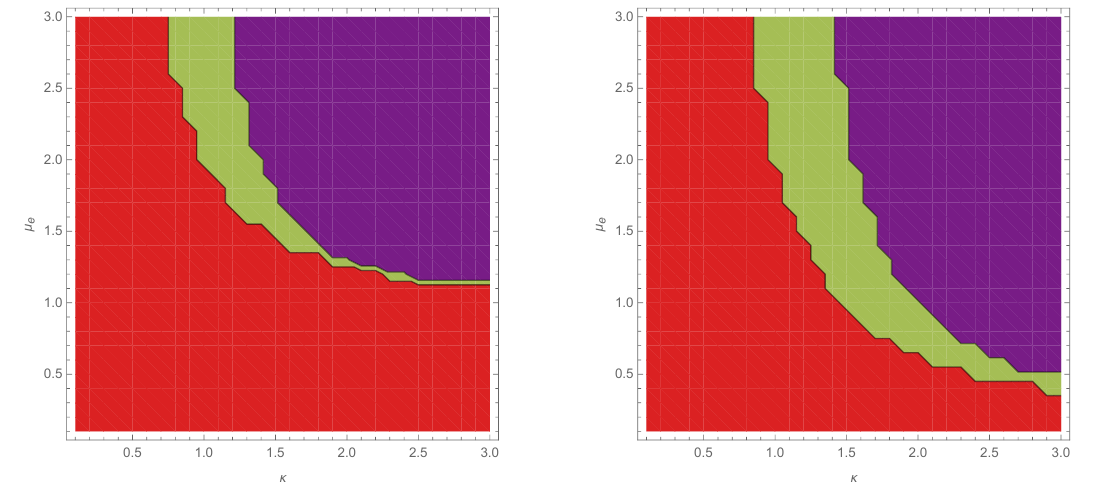
Figure 2 . Both signs of (cid:11) e ( r min ) can be found for (cid:21) > 0 and for (cid:21) < 0. The cases D = 3 (left) and D = 4 (right) are shown. The (cid:12)gure displays results at (cid:21) = 0, but (cid:11) e ( r min ) is continuous so the results for small positive or negative (cid:21) are essentially identical. Regions with (cid:11) e ( r min ) > 0 are shaded red while those with (cid:11) e ( r min ) < 0 are shaded green. In the purple regions V < 0 at all r and Euclidean solutions do not